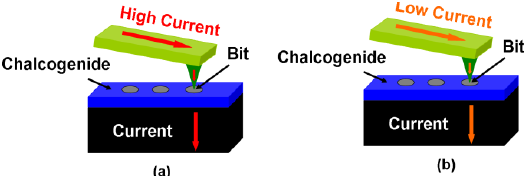
Figure 1. The electrical probe memory using Chalcogenide media when operated in ( a ) write mode and ( b ) readout mode.